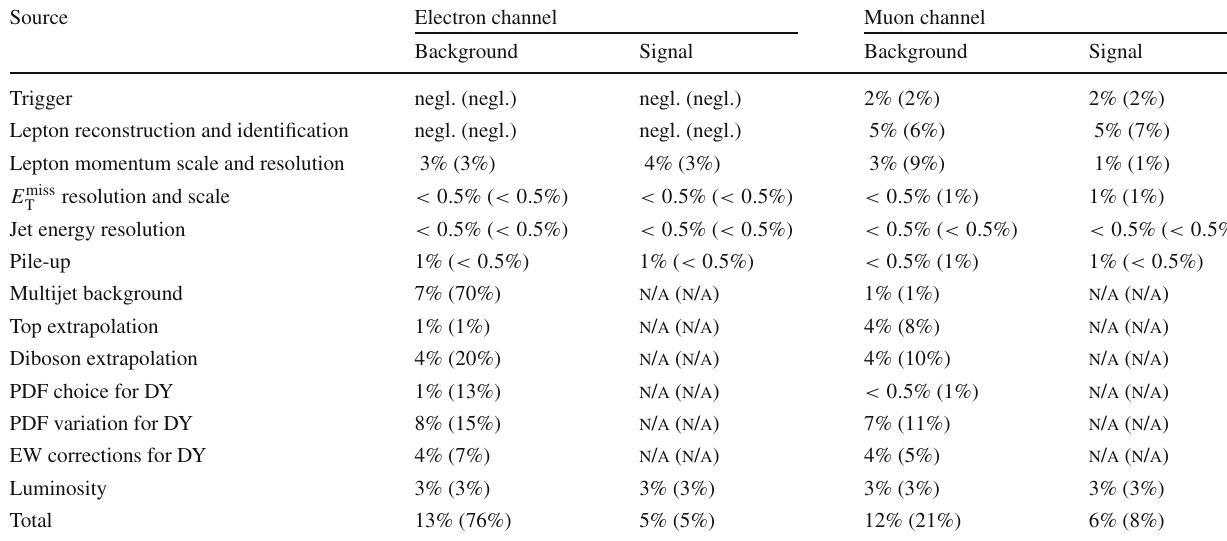
Table 2 Systematic uncertainties in the expected number of events as estimated for the total background and for signal with a W (cid:2) 2 (4) TeV. The uncertainty is estimated with the binning shown in Fig. 1 at m T = 2 (4) TeV for the background and in a three-bin window around